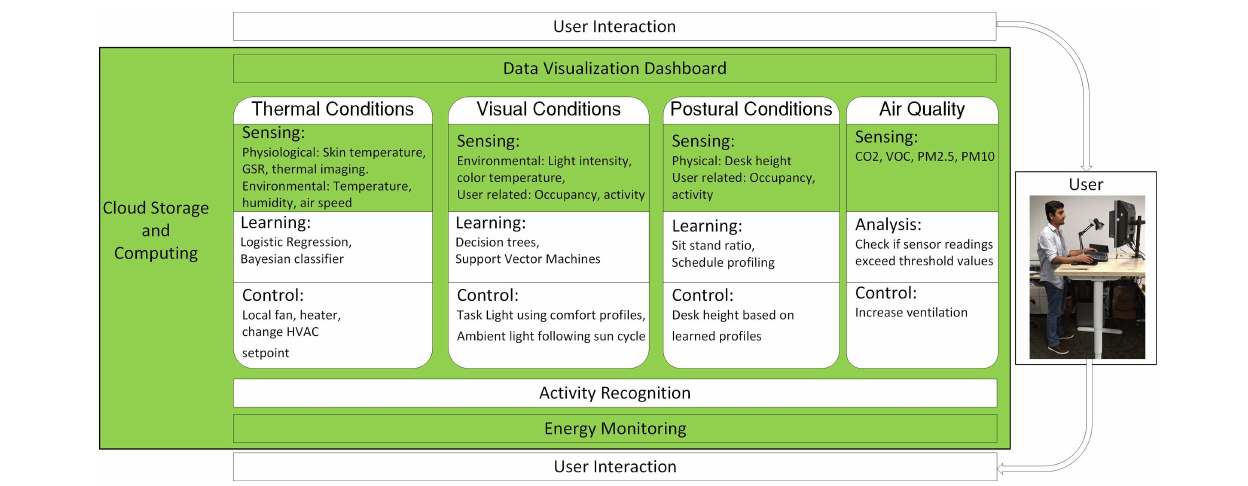
Frontiers in Built Environment |